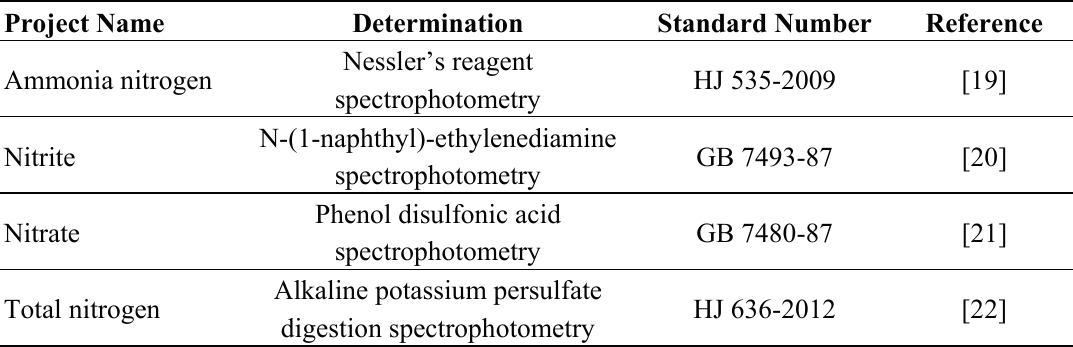
Table 1. Methods of determination.